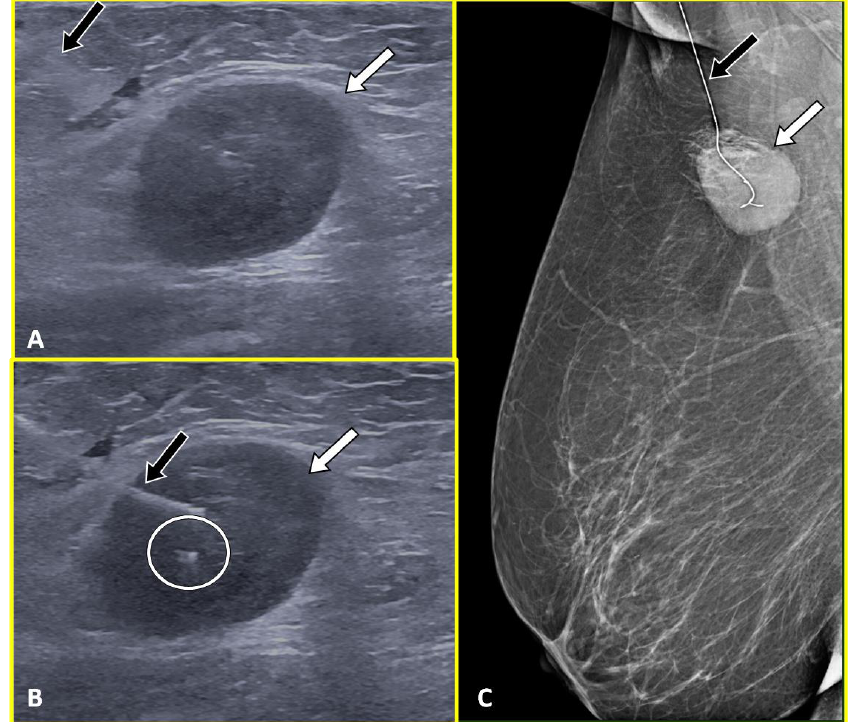
Figure 5. A 72-year-old woman with biopsy-proven right axillary node metastasis by a luminal B breast cancer for which the primitive tumor was not identified. Ultrasound preoperative wire localization ( A , B ) shows the wire (black arrow) positioned inside the pathological node (white arrow in ( B )); a marker clip (white circle) within the node was previously placed. Post-procedural medio-lateral oblique ( C ) right mammogram confirmed the position of the wire (black arrow) within the node (white arrow).